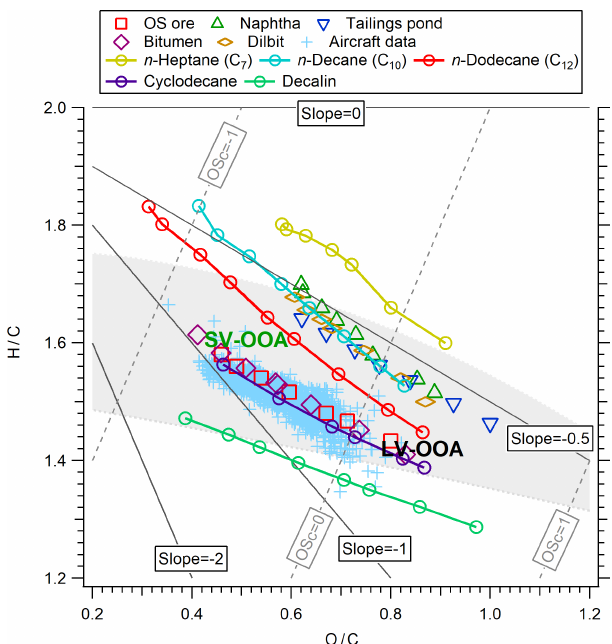
Figure 7. Van Krevelen diagram for the SOA formed from OS- related precursors, selected alkanes, and recent aircraft data in OS plumes (Liggio et al., 2016). The shaded area represents the ele- mental ratio space associated with ambient OOA (Ng et al.,